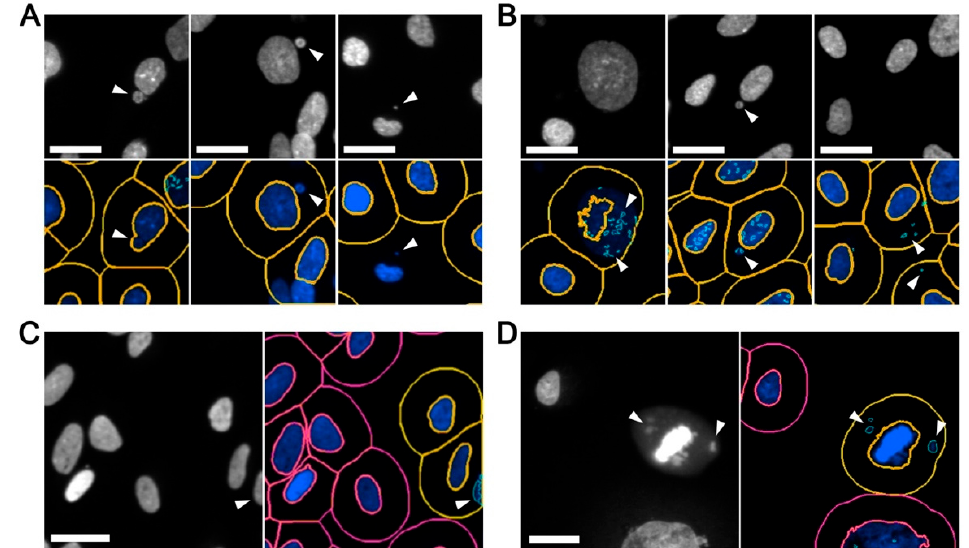
Figure 2. Optimizing image segmentation to enhance micronucleus enumeration. Examples of common detection errors that must be optimized to accurate ensure micronucleus enumeration. Note that only magnified portions of the original 20 × images are presented. ( A ) Inadequate image segmentation associated with false negative errors such as micronuclei that are erroneously incorporated into the primary (nuclear) mask (left), micronuclei that are not identified within the secondary (cell body) mask (middle), or, micronuclei located outside the secondary mask (right). Scale bars represent 25 µ m. ( B ) Inappropriate image segmentation leading to false positive errors including under segmented images (left and middle), leading to excessive calling of micronuclei, or over segmented images in which background elements are identified as micronuclei (right). Scale bars represent 25 µ m. ( C ) Inaccurate segmentation of elements along the image periphery, resulting in false positive errors. Scale bar represents 30 µ m. ( D ) Inclusion of mitotic cells in which mitotic chromosomes are erroneously identified as micronuclei. Scale bar represents 30 µ m. Note that (A) and (B) are FT246 cells treated with etoposide and bleomycin, respectively, while (C) and (D) are negative controls (dimethyl sulfoxide [DMSO]